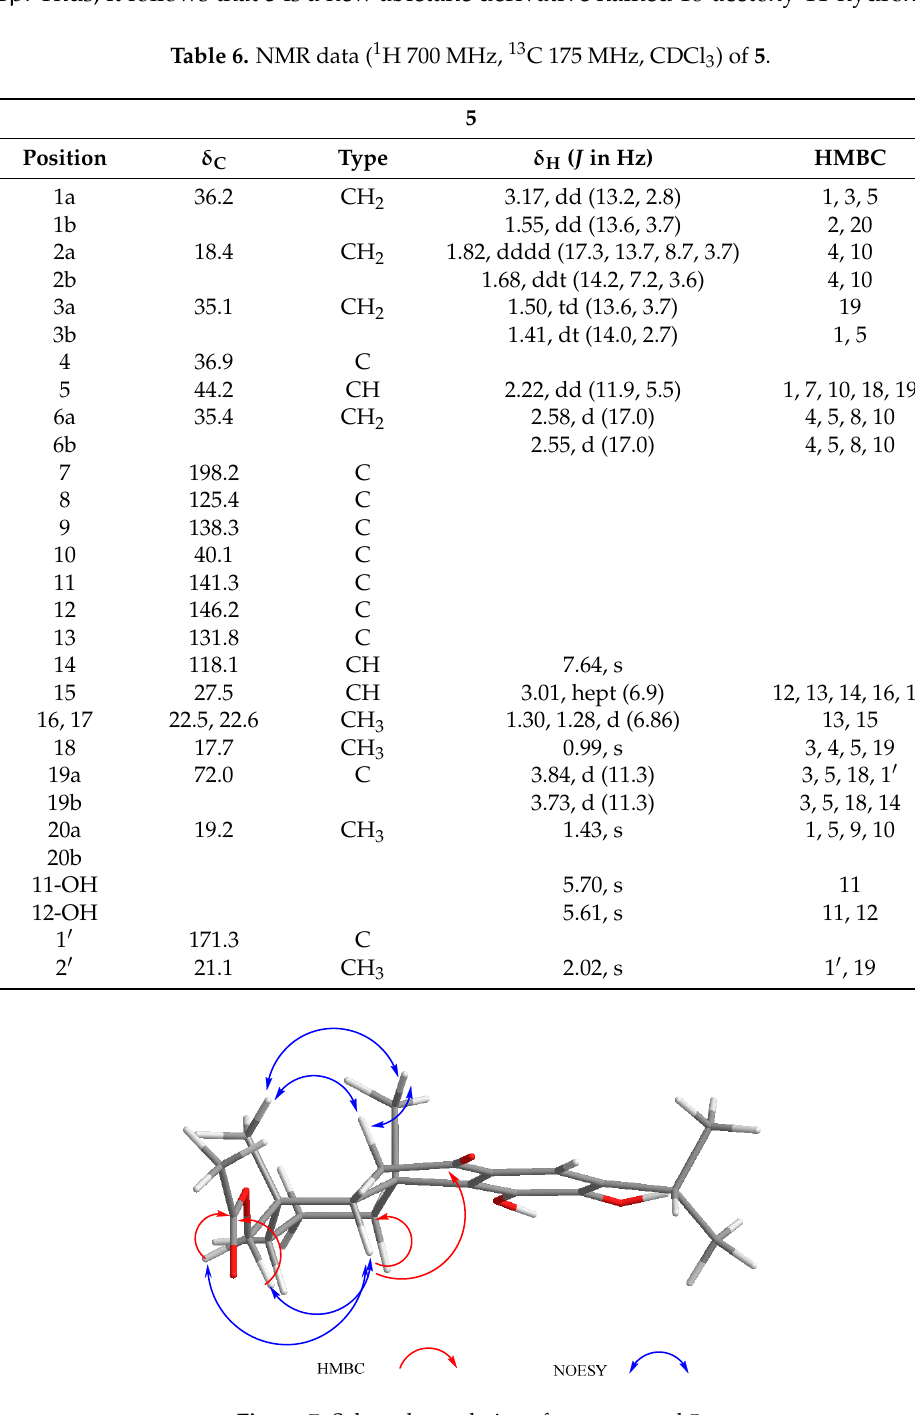
Figure 7. Selected correlations for compound 5 .